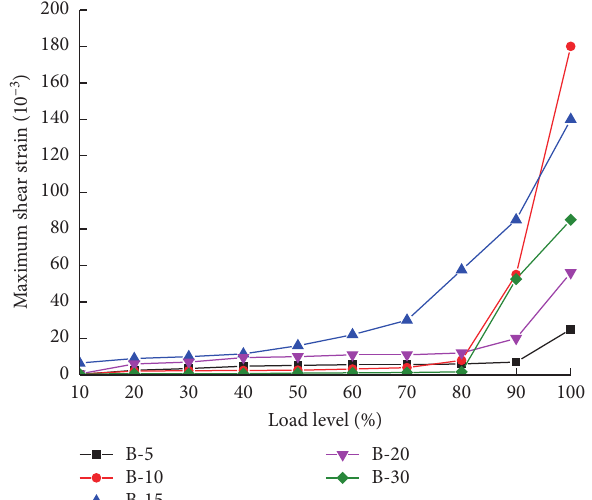
Figure 11: Evolution of maximum shear strain of jointed specimens with different undulating